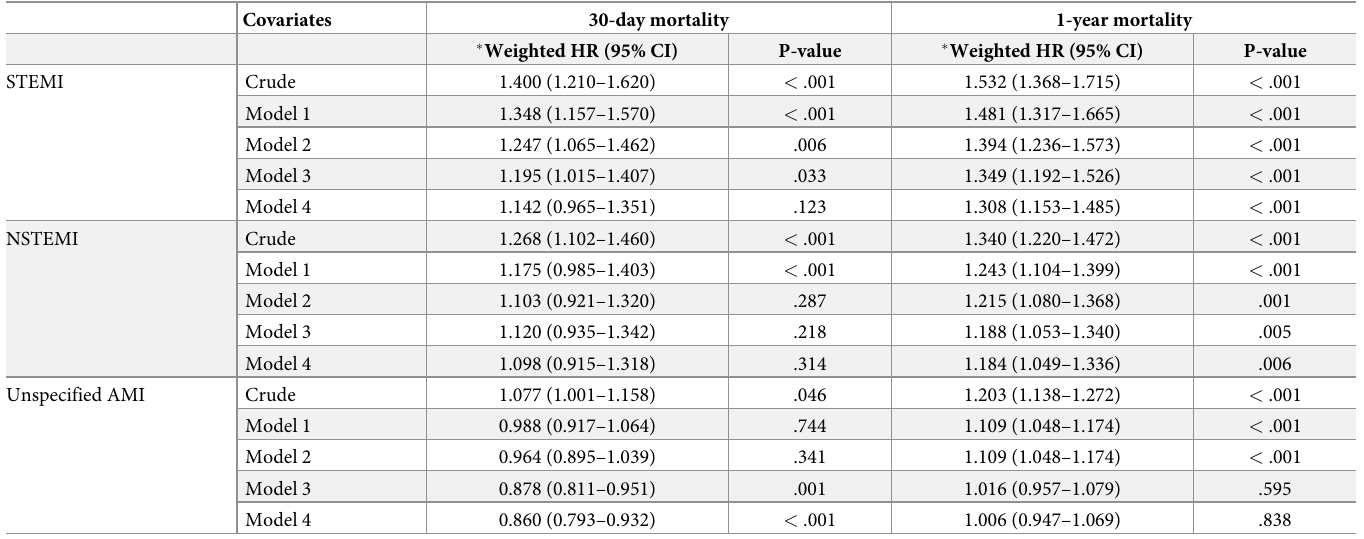
Table 4. Crude and weighted hazard ratios of transfer on the short- and long-term mortality according to the class of acute myocardial infarction.